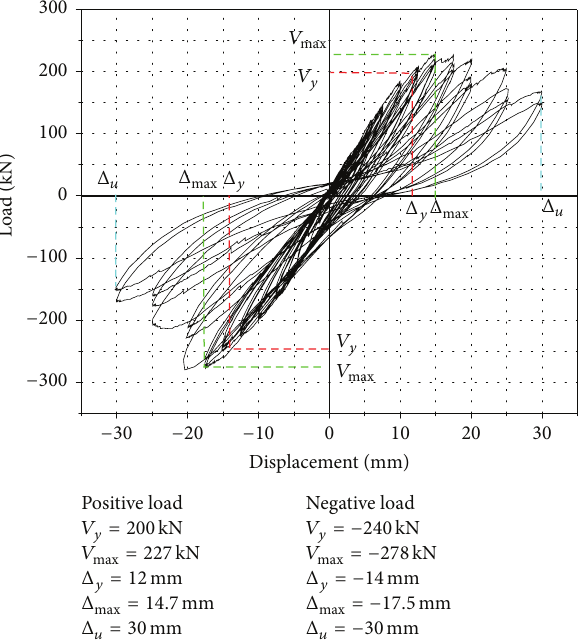
Figure 8: Lateral load-displacement curve for the SF-0